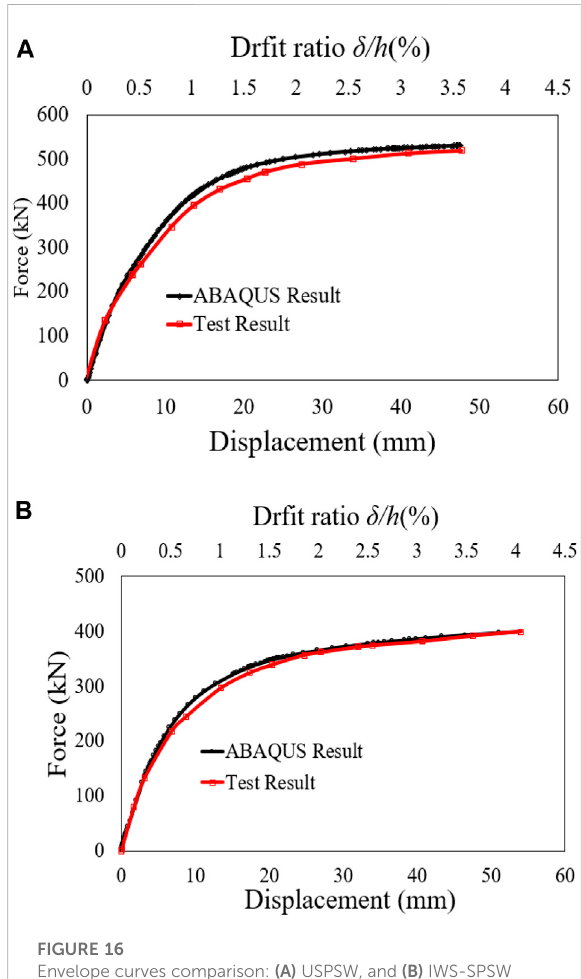
FIGURE 16 Envelope curves comparison: (A) USPSW, and (B) IWS-SPSW